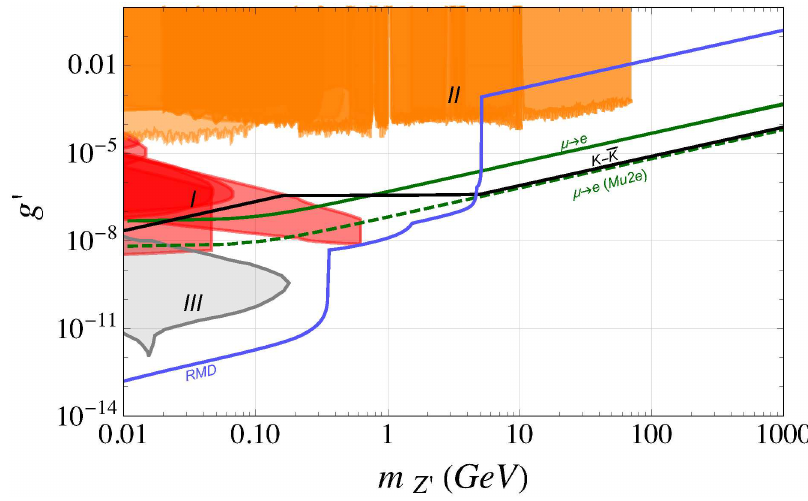
Figure 1 . The strongest bounds on the Z 0 mass as a function of gauge coupling g 0 of the horizontal G FN = U(1) FN group, setting kinetic mixing to zero. Region I (II) collects bounds due to the direct production of Z 0 in proton and electron beam dumps (at e + e − colliders), while Region III shows the exclusion from SN1987A. The solid (dashed) dark green line depicts the present (future) µ → e bound, the solid black line the bound from K − ¯ K mixing, the solid blue line the limits from rare meson decays (RMD), see text for